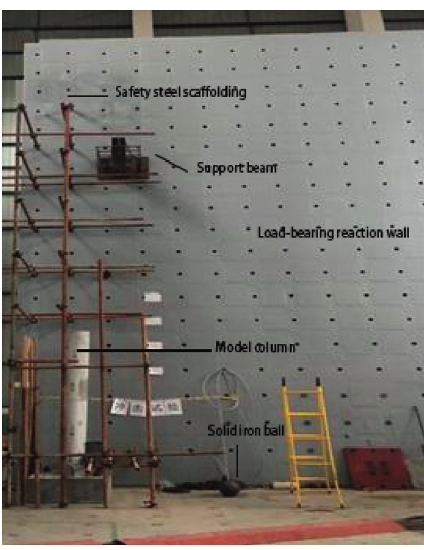
Figure 12: Final test device.